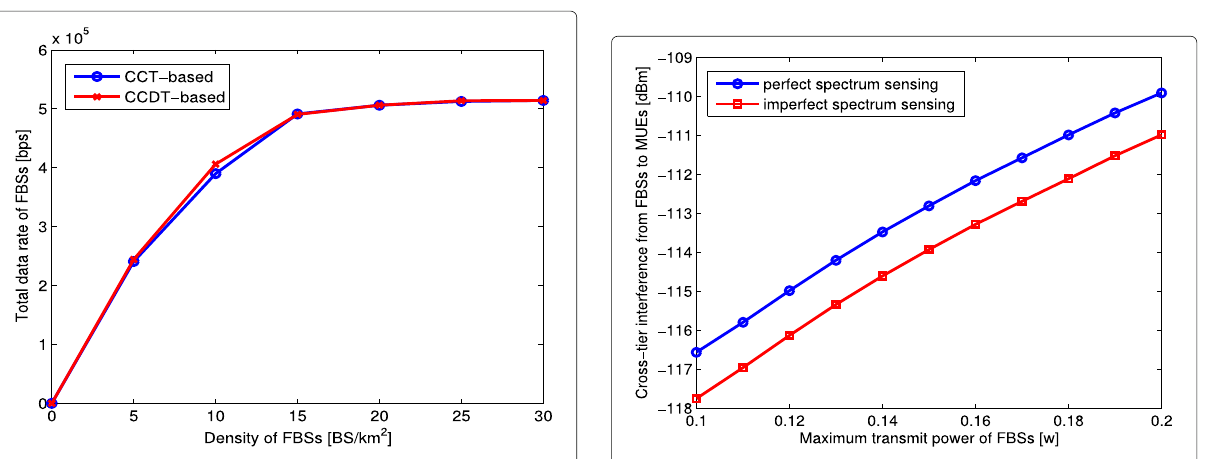
Fig. 5 Total data rate of FBSs for different density of FBSs